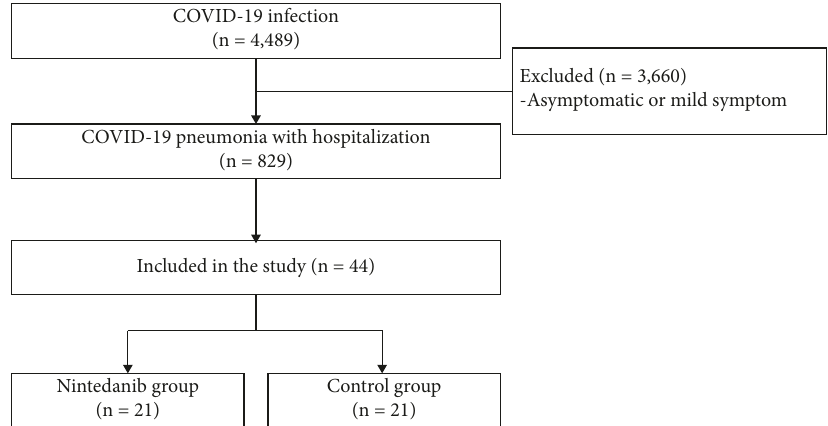
Figure 1: Flowchart of COVID-19 patients included in the SpO /FiO ratio and oxygen therapy before antifibrotic or 2 2 standard treatment (Table 1). Mean duration of antifibrotic